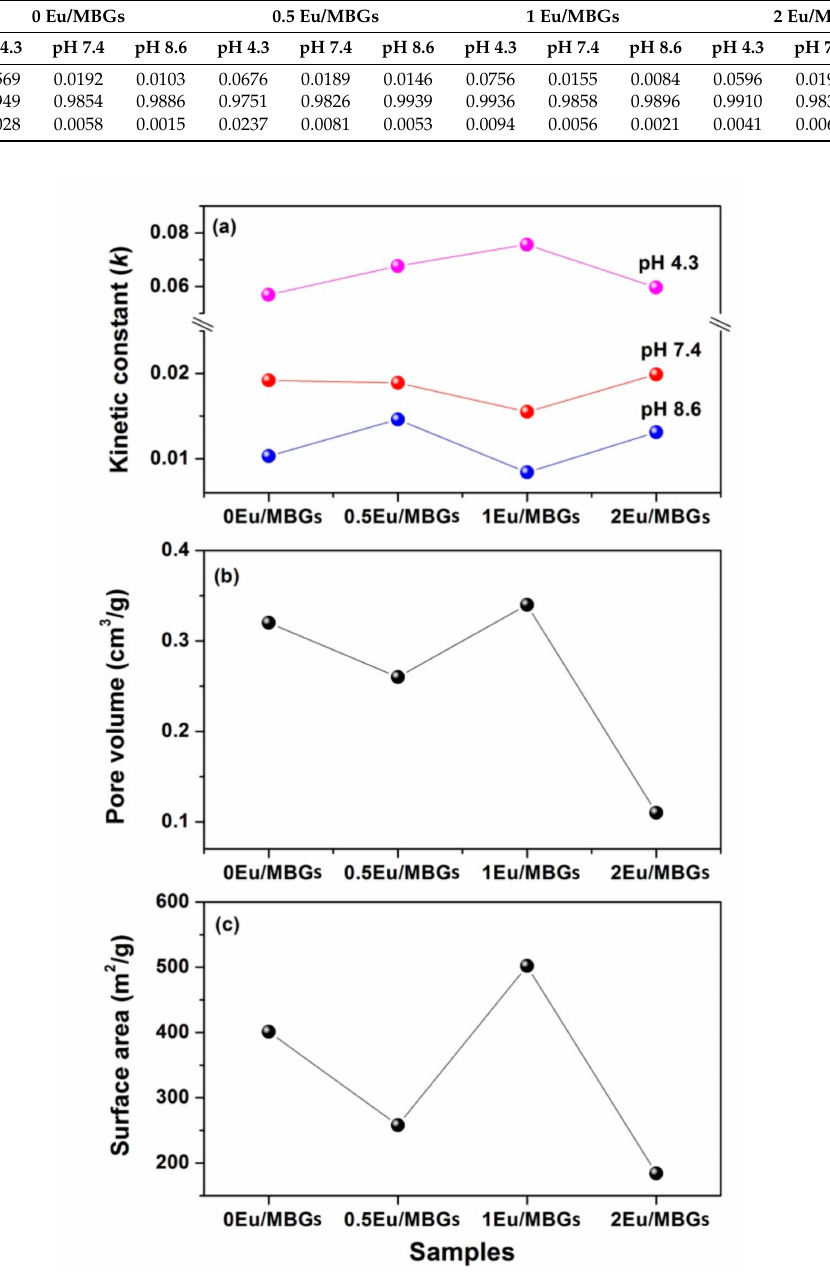
Figure 6. Kinetic constant ( a ) and microstructure parameters (surface area ( b ) and pore volume ( c )) of